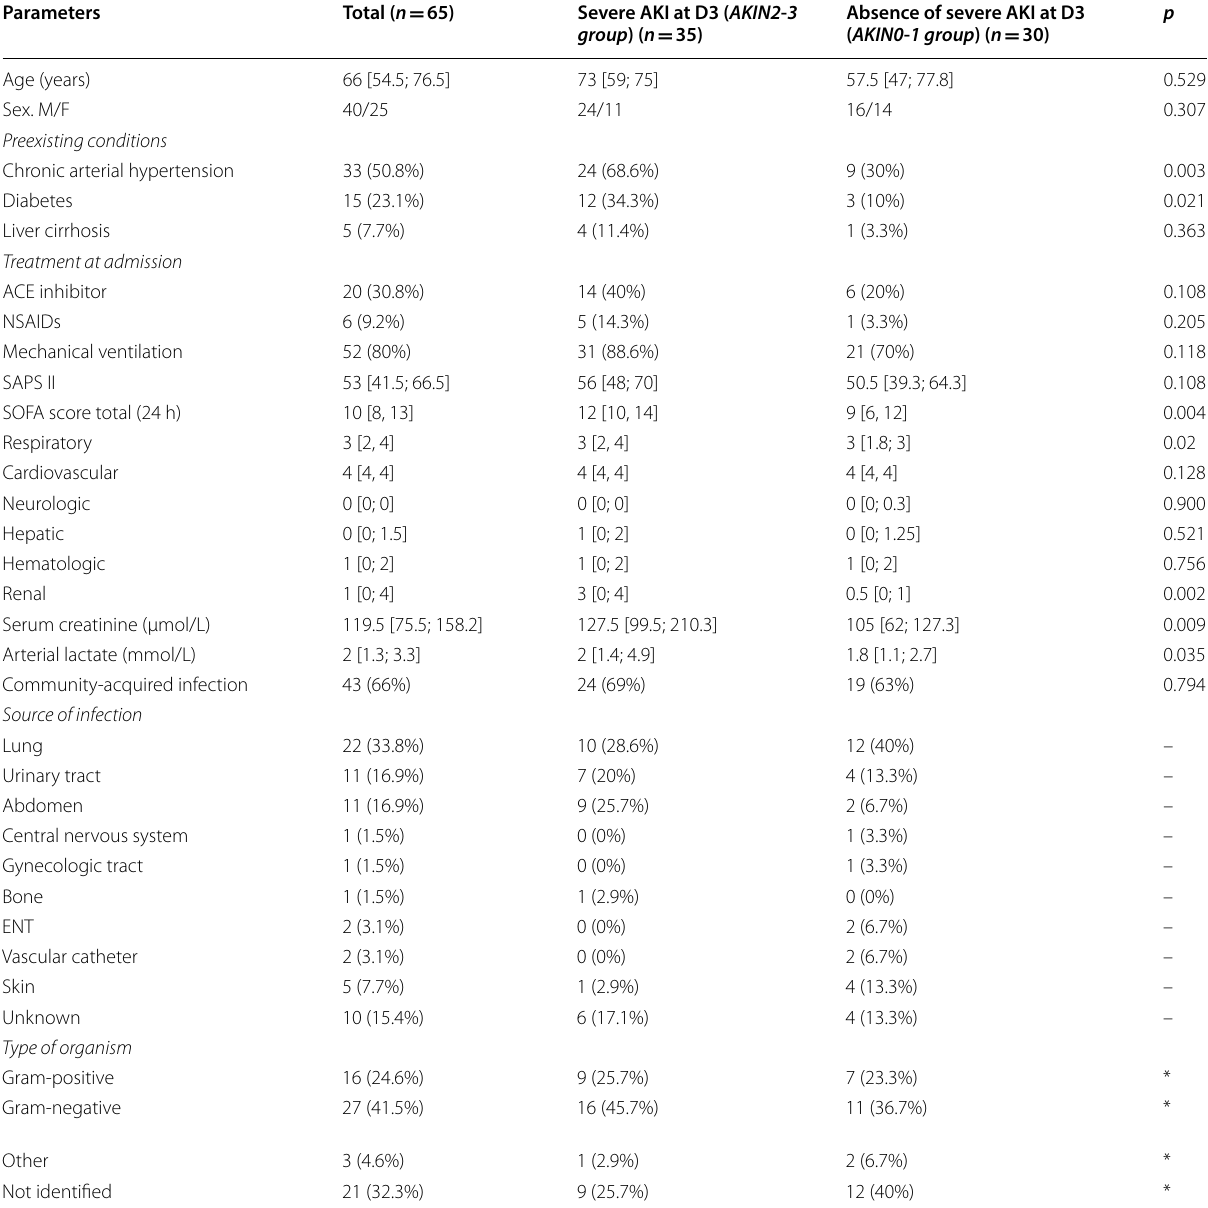
Table 1 Patient characteristics at inclusion according to the presence or absence of severe acute kidney injury (AKI AKIN 2 or 3 at day